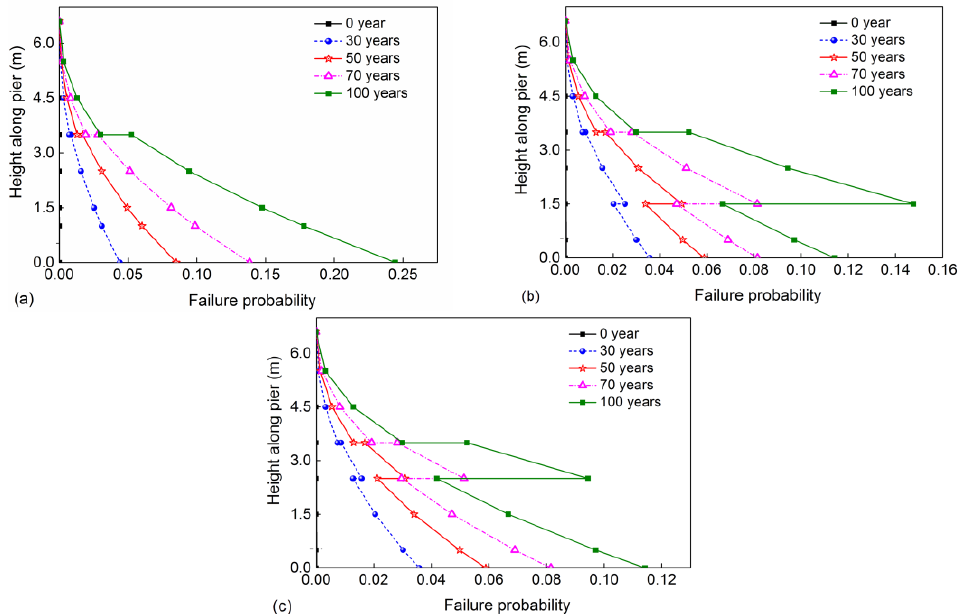
Figure 15. Sectional failure probability along the pier elevation: ( a ) case 1; ( b ) case 2; ( c ) case